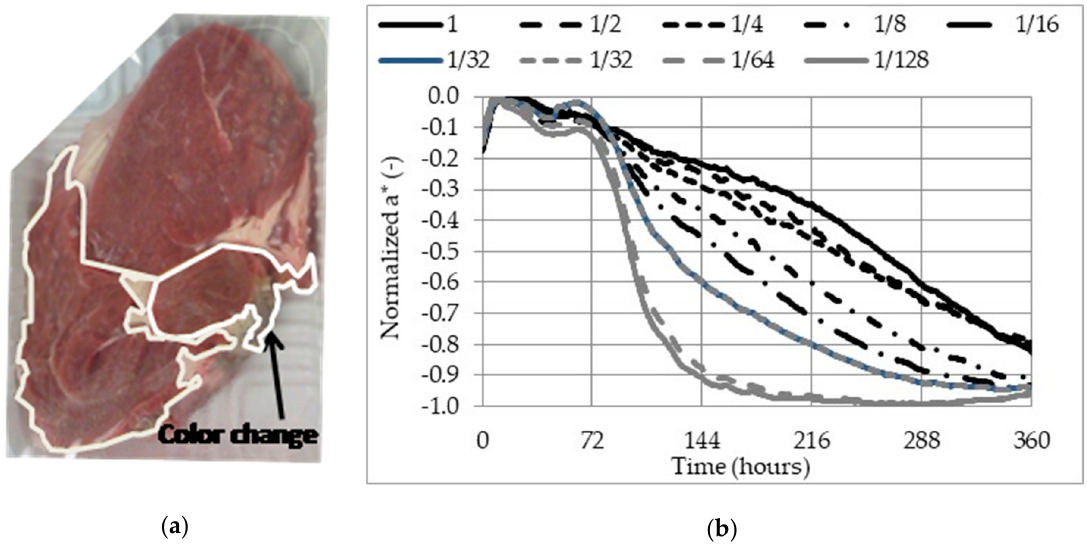
Figure 5. ( a ) Example of a limit detection of the color transfer, using a surface of 1/2 (white separation); ( b ) normalized a* values for different areas of meat measured for the same sample (area divided by 1, 2, 4, 16, 32, 64, and 128) over time.